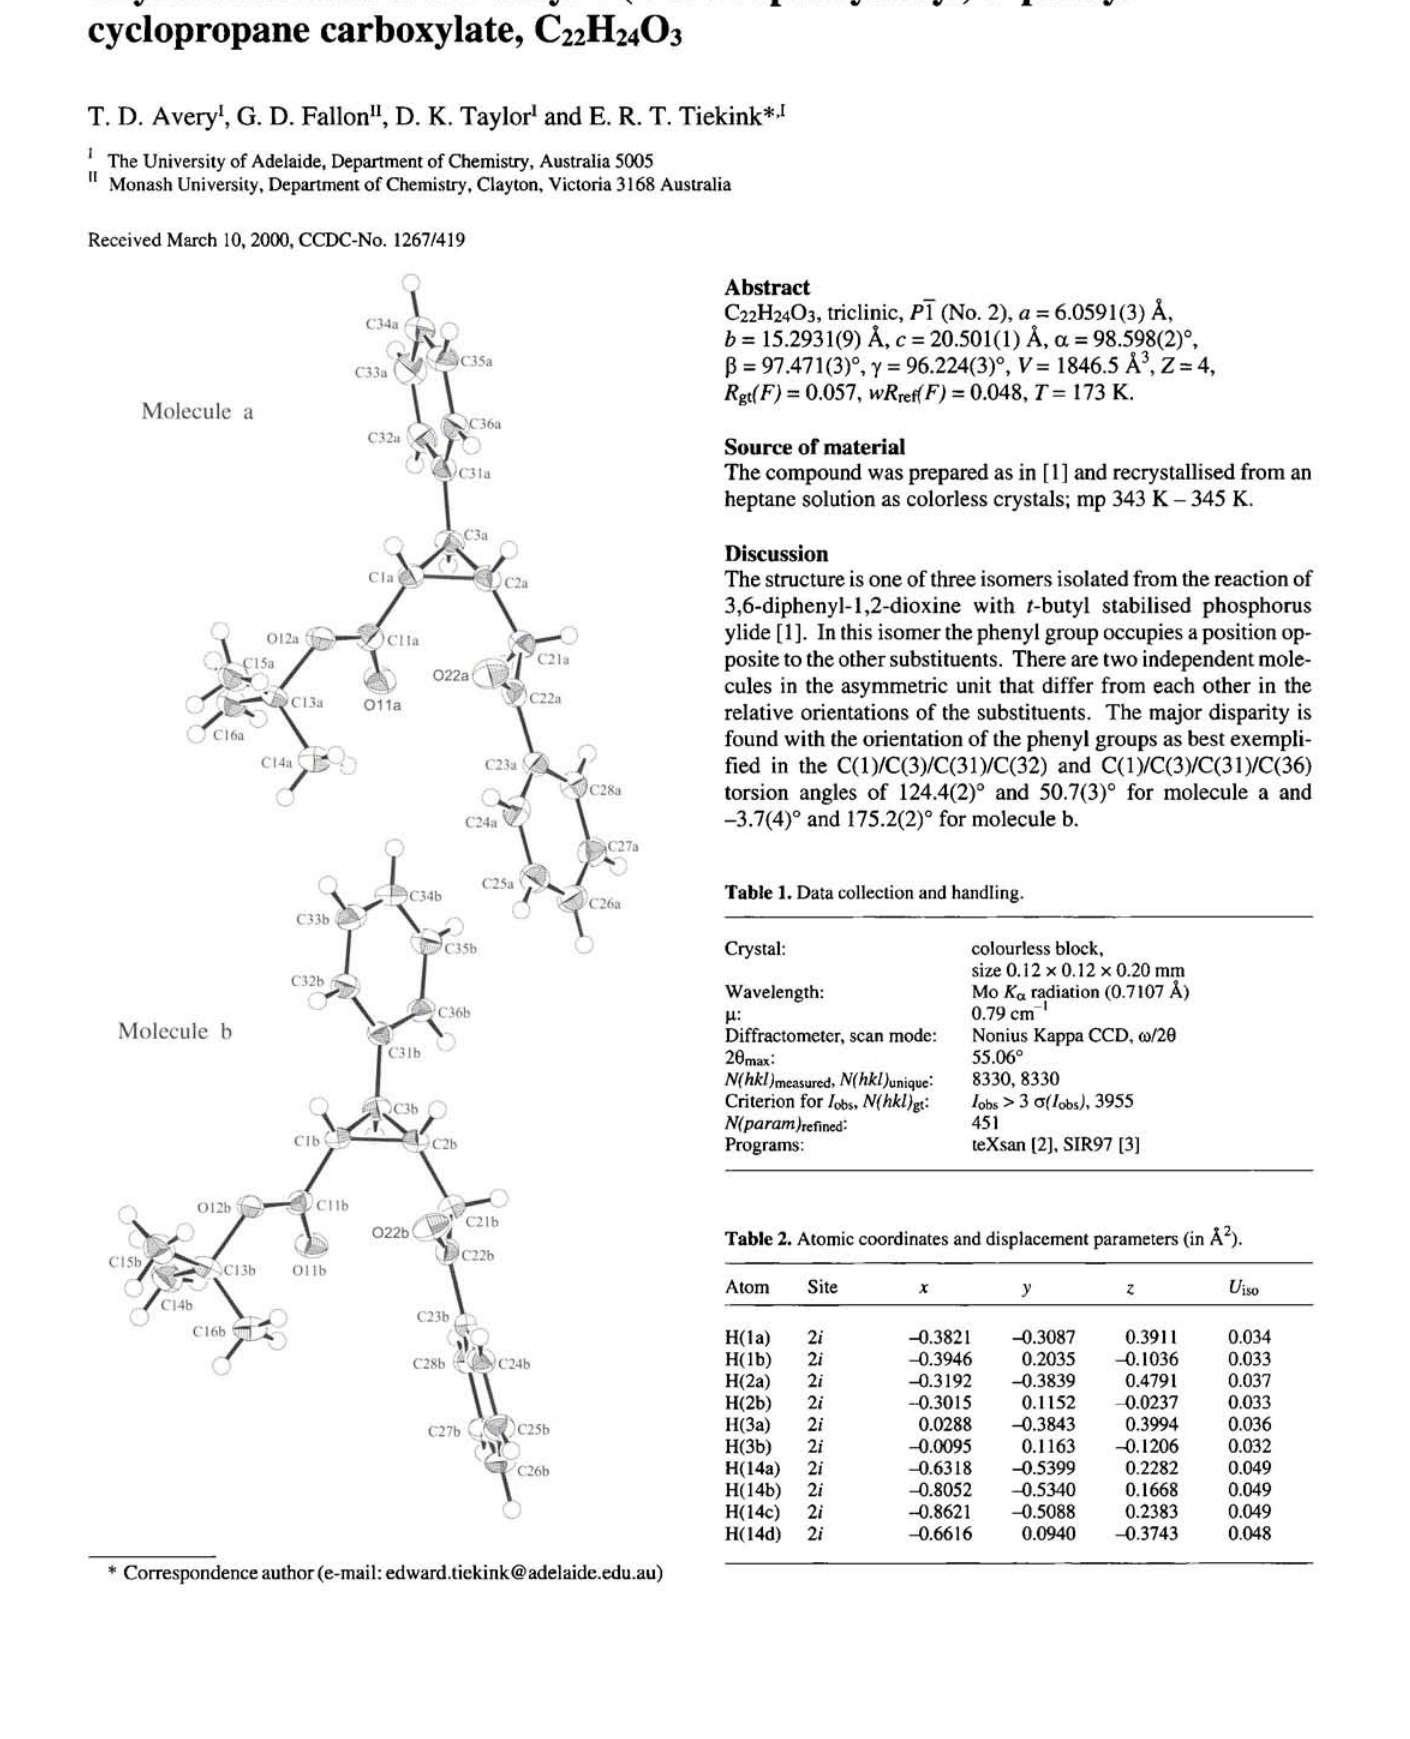
Table 2. Atomic coordinates and displacement parameters (in Â 2